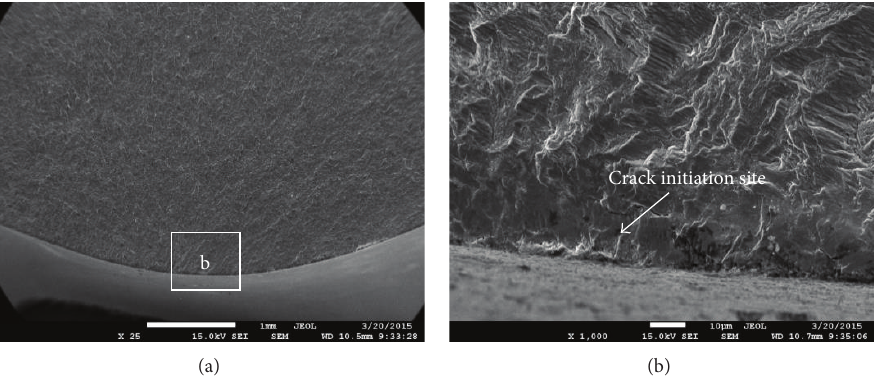
Figure 9: Fracture surface of the CN: (a) fracture surface and (b) crack initiation